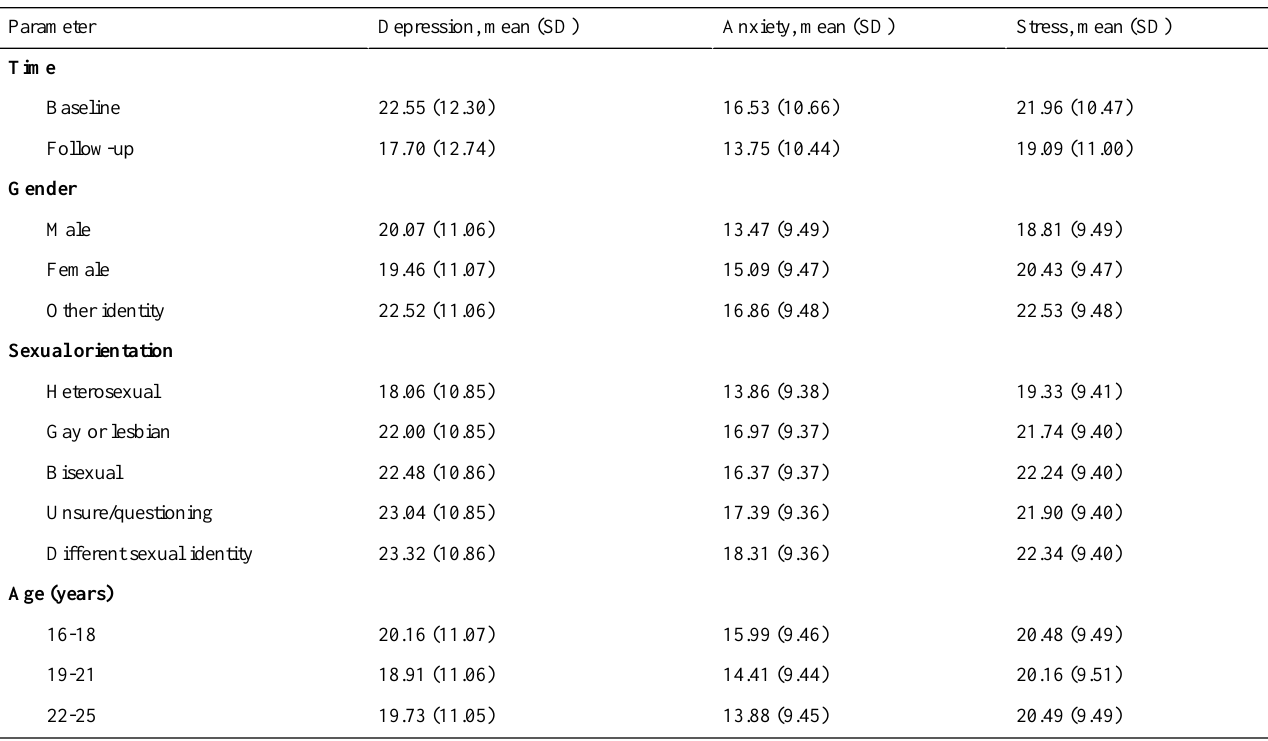
Table 2. Means and standard deviation for depression, anxiety, and stress across time, gender, age group, and sexual orientation.